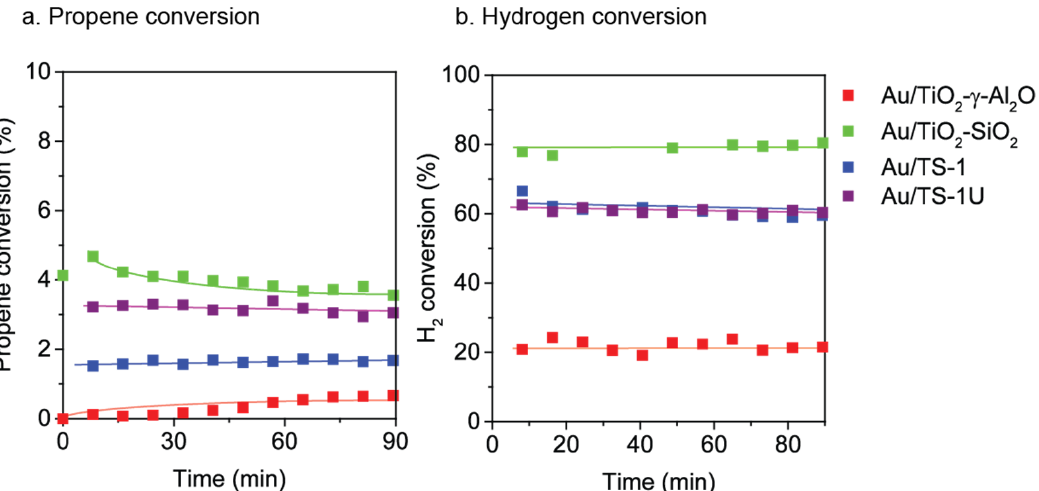
Figure 10 . Conversion during propene ( a ) and hydrogen ( b ) oxidation over gold catalysts supported on Ti 4+ -modified materials. Conditions: 150 mg of catalyst, 10,000 mL/g cat /h flow of 10% of each C 3 H 6 , O 2 and H 2 in He at 200 °C.